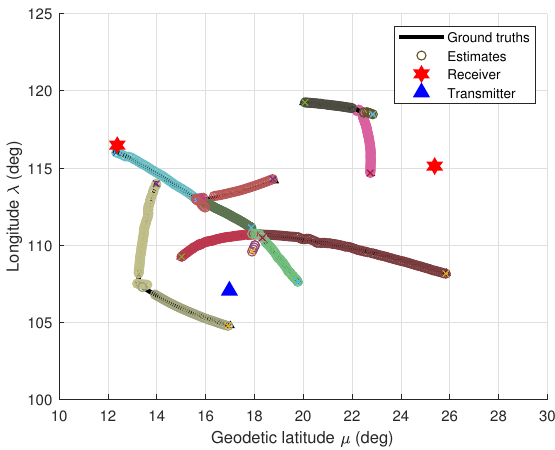
Figure 2. Configuration of multitarget tracking using MRS.